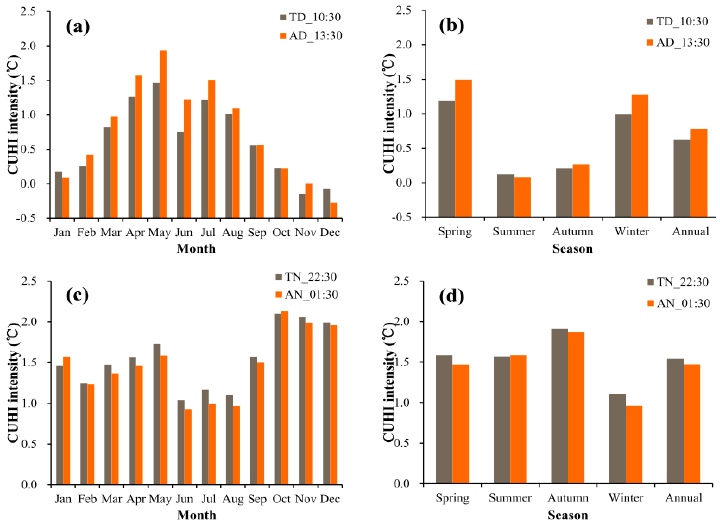
Figure 7. Multi-annual monthly and seasonal mean daytime and nighttime CUHI intensity calculated form meteorological stations at the four Terra/Aqua-MODIS overpasses during the period 2000–2013 for Terra and 2002–2013 for Aqua in Shanghai. CUHI intensity is defined as the air temperature difference between Xujiahui and Fengxian meteorological stations. ( a ) monthly mean daytime CUHI intensity; ( b ) seasonal mean daytime CUHI intensity; ( c ) monthly mean nighttime CUHI intensity; and ( d ) seasonal mean nighttime CUHI intensity.